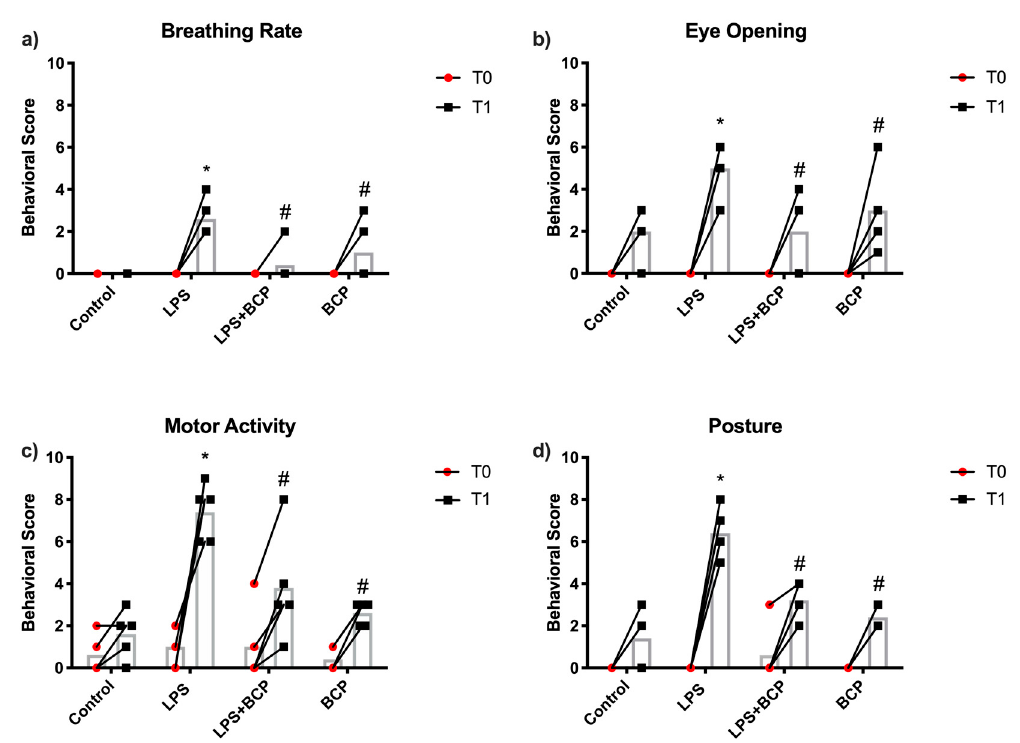
Figure 9. Behavioral score for each category of female BALB / c mice; ( a ) breathing rate, ( b ) eye opening, ( c ) motor activity, ( d ) posture, before cystitis induction (T0) and after treatment (T1) for the following experimental groups: healthy control animals (Control, n = 5), LPS-induced IC (LPS; n = 5), LPS-induced IC treated with oral BCP (100 mg / kg, LPS + BCP; n = 5), and healthy animals administered BCP (100 mg / kg, BCP; n = 5) All groups were pretreated with olive oil gavage, with the treatment groups receiving BCP dissolved in olive oil. Saline and LPS were administered via intravesical instillation. Data presented as the mean score ± SD for each parameter. Individual data points are also shown. * p < 0.05 vs. Control, # p < 0.05 vs. LPS.